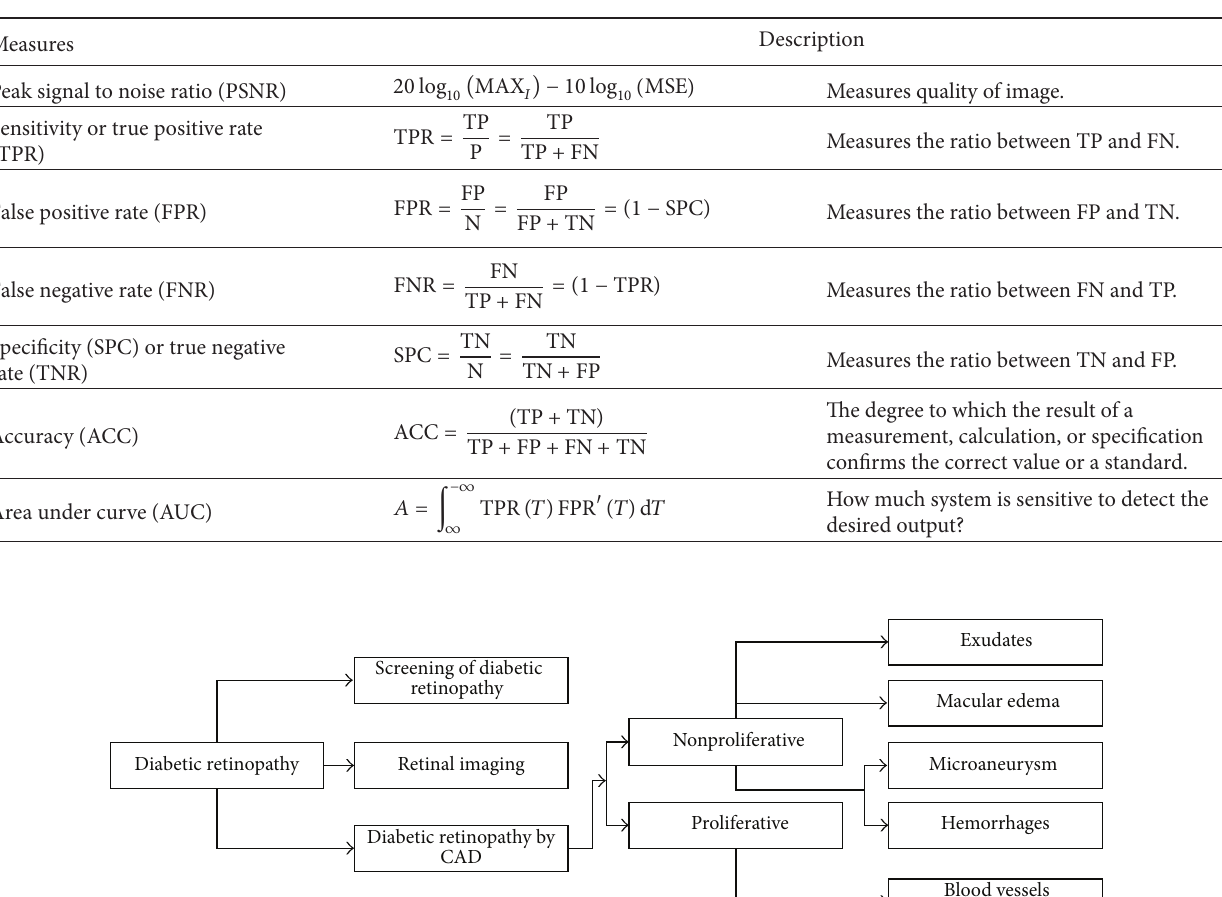
Table 2: Performance metrics.